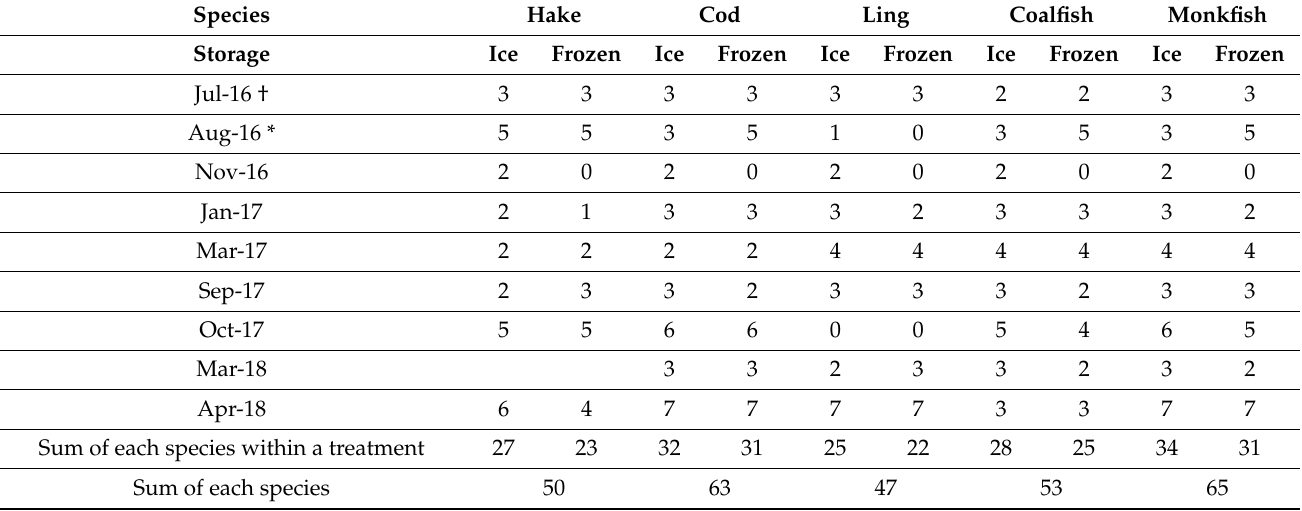
Sum of each species within a treatment Sum of each